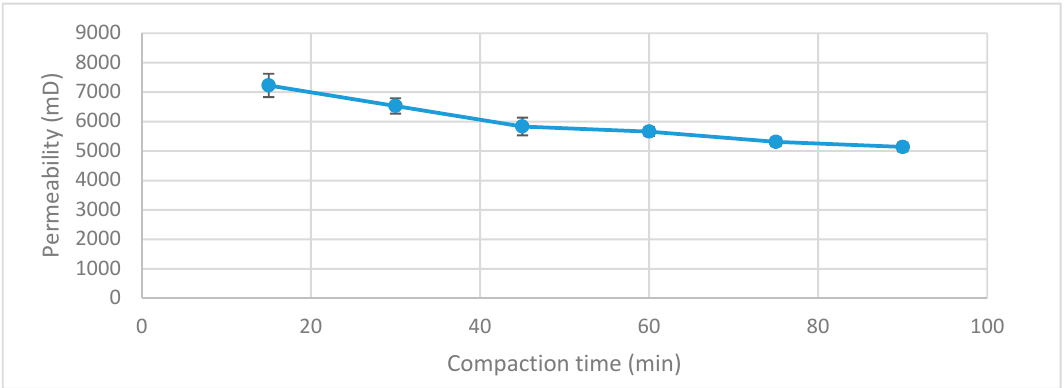
Figure 3. The compaction time against permeability tested in 15 min intervals for 3 runs at each compaction time, revealing the high repeatability of the packing method especially after 1 h of packing.